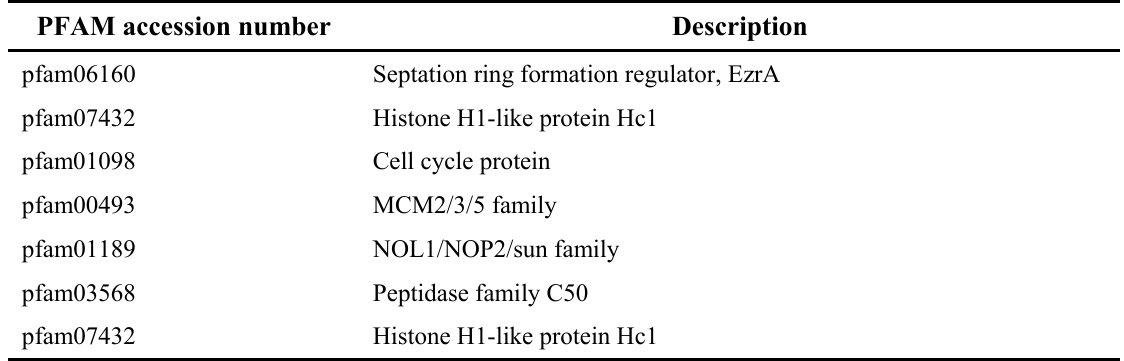
Table 5: PFAM accession numbers for protein families involved in cell cycle process in bacteria PFAM accession